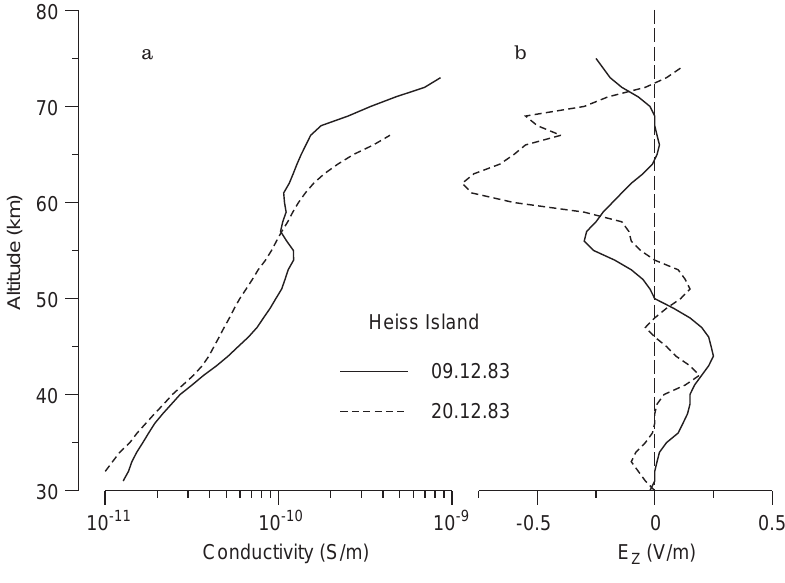
Fig. 3. The altitude profiles of a the total ion conductivity and b the vertical electric fields measured simultaneously above Heiss Island